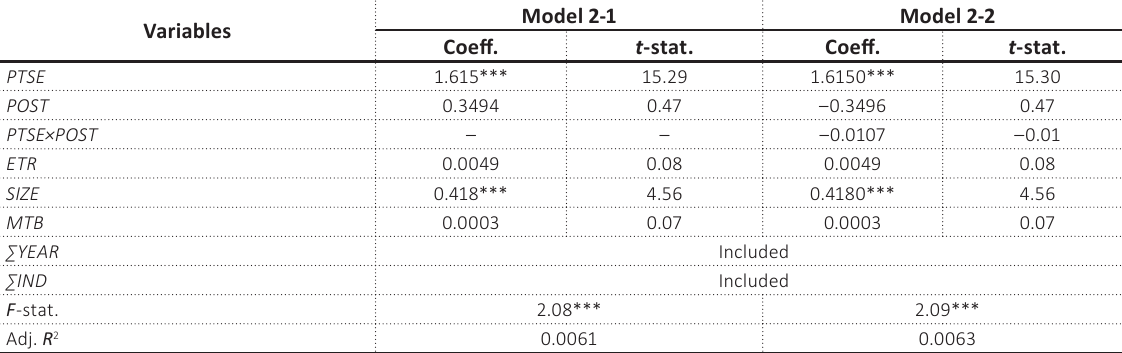
Table 5. Regression results: effects of the global financial crisis on the realization of an implicit tax